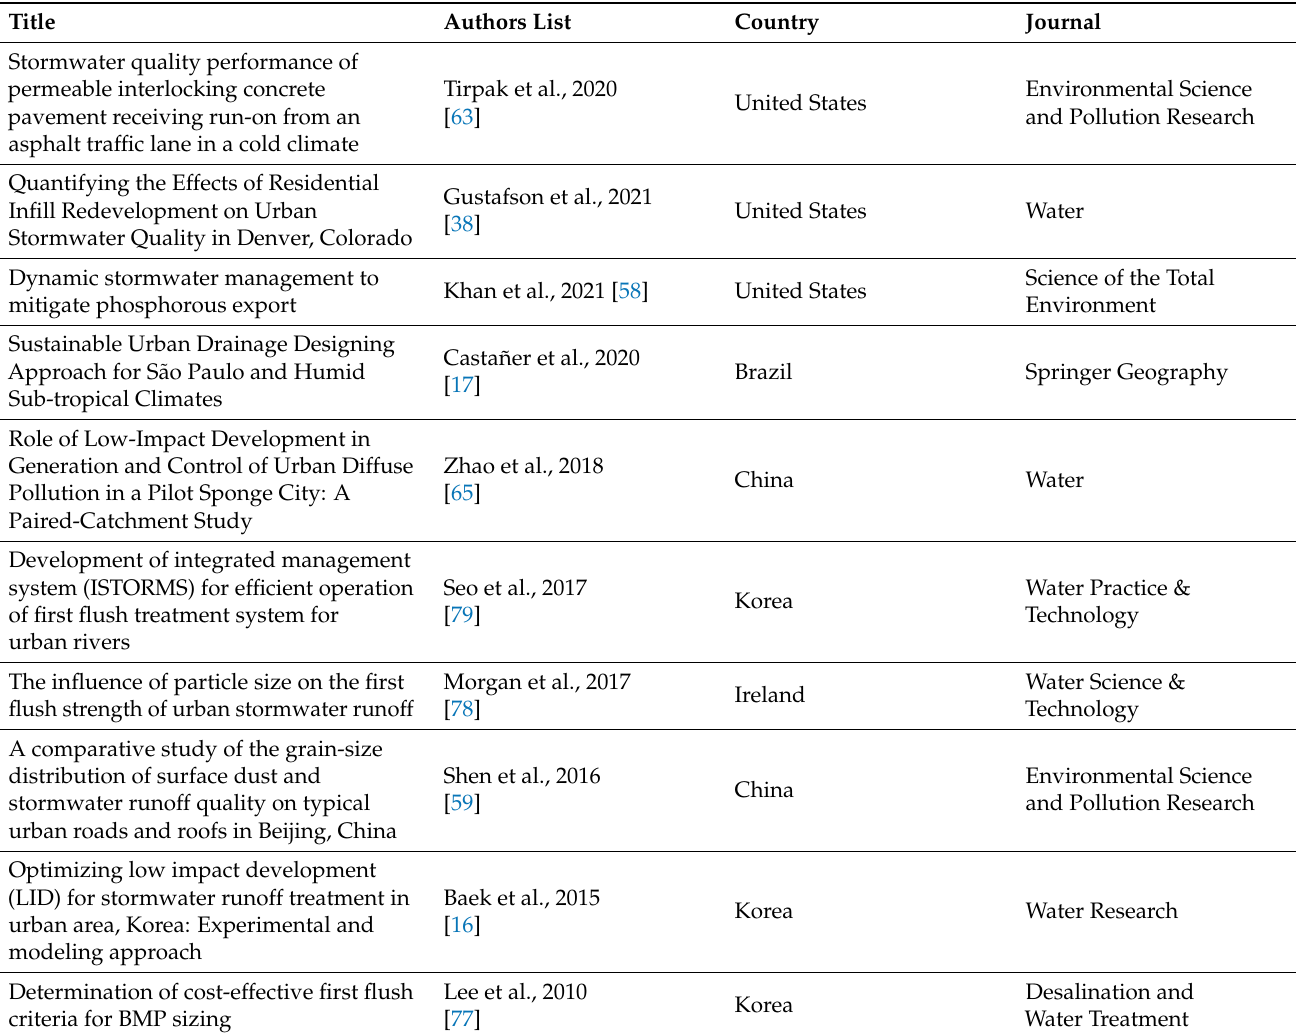
Table 4. Summary of articles associated with the concept of low impact development (LID) or best management practices